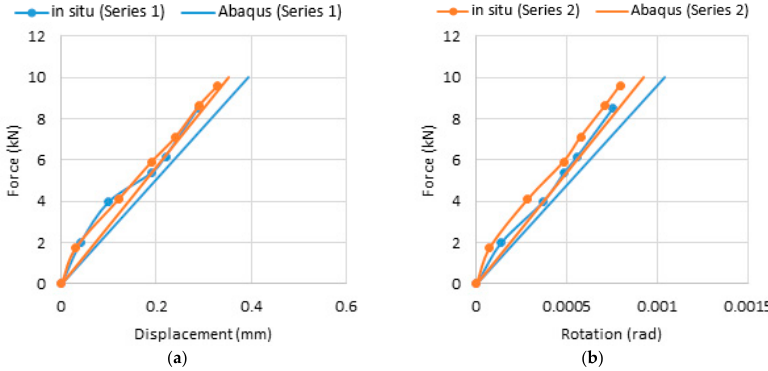
Figure 10. Test scheme C results for ( a ) force vs. displacement and ( b ) force vs. rotation. A comparison of measurements in the shaft and numerical simulations indicates strong agreement between the obtained results. Deformation characteristics for in situ testing show small variations around the linear trend, which may be explained by clear- ance levelling in the dynamometer and bolted connections but have a negligible impact